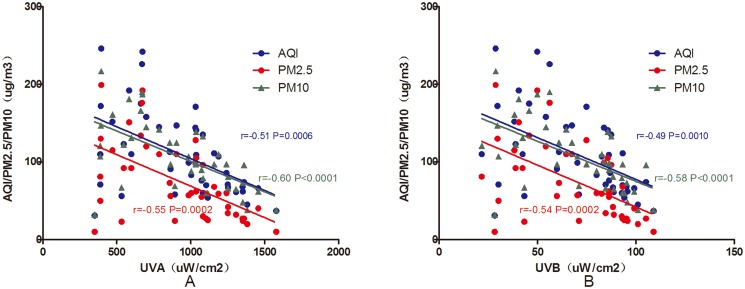
The relationship between UVA and UVB intensity and air quality parameters (AQI, PM2.5, and PM10).A: Pearson’s correlation analysis demonstrated a significant negative correlation between UVA intensity and air quality parameters (AQI: r = -0.51, P = 0.0006; PM2.5: r = -0.55, P = 0.0002; and PM10: r = -0.60, P<0.0001). B: Pearson’s correlation analysis revealed a significant negative correlation between UVB intensity and air quality parameters (AQI: r = -0.49, P = 0.0010; PM2.5: r = -0.54, P = 0.0002; and PM10: r = -0.58, P<0.0001).